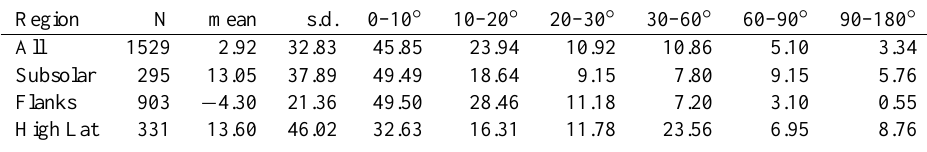
Table 9. Distribution of angular differences, filtered for IMF cone angle between 45 ◦ and 135 ◦ . Format as in Table 3. Region N mean s.d. All 965 − 0.25 Subsolar 340 Flanks 288 − 5.66 High Lat 337